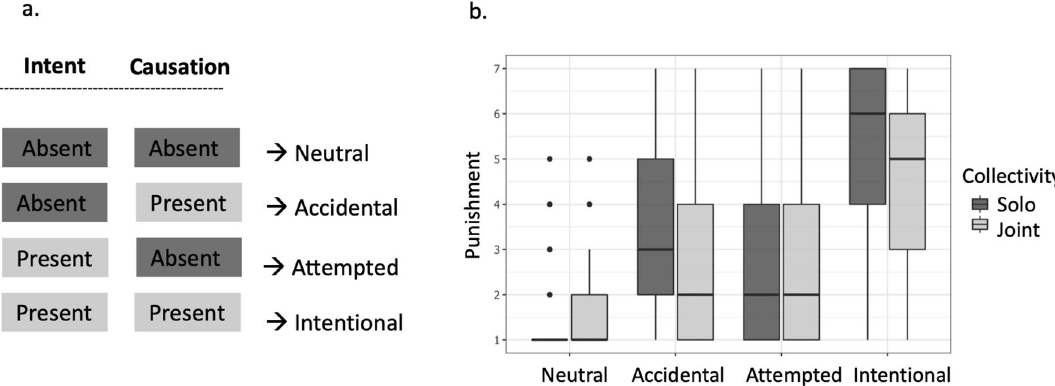
Figure 2. ( a ) The four experimental conditions as the outcome of a 2 × 2 design crossing Malicious Intent (absent vs. present) and Causation of Harm (absent vs. present). ( b ) Box-and-whisker plot of punishment ratings as a function of Collectivity (different colors) across neutral, accidental, attempted, and intentional actions (horizontal axis). The box represents the middle 50% of scores. The thick horizontal line within each box represents the median. Upper and lower whiskers show the range of scores in the highest and lowest quartiles. The dots represent